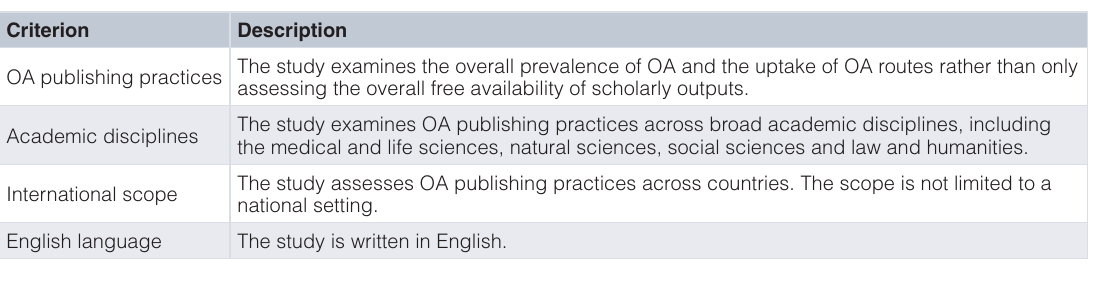
Table 2. Selection criteria literature